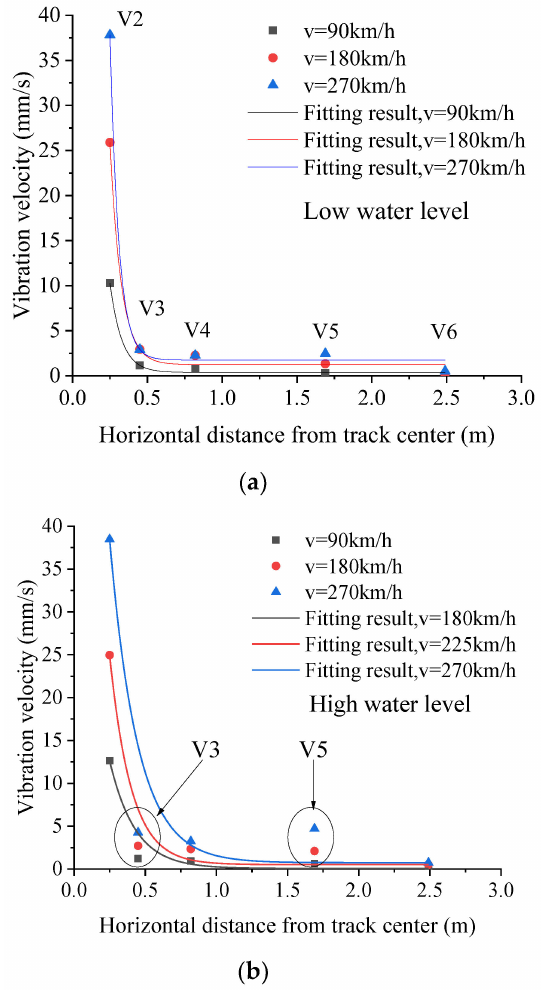
Figure 14. Fitting curves of peak velocity in horizontal direction along with distance from the track center. ( a ) Low water level, ( b ) High water level. Figure 15 and Table 4 show the distribution and decrease percent of peak velocity along the depth of roadbed surface. Table 4. Peak velocity decrease percent in vertical direction along the